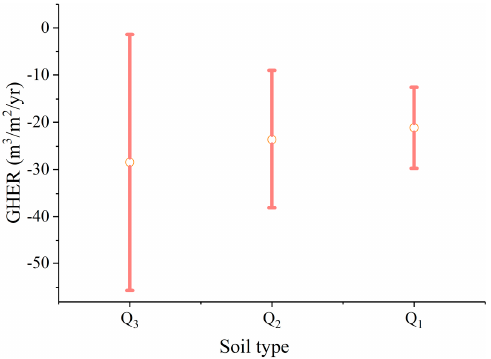
Figure 17. Mean ± standard error of GHER as a function of the soil type.